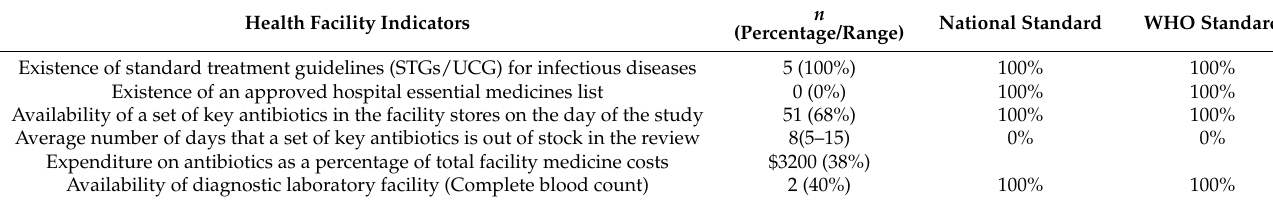
Table 6. Showing results for health facility